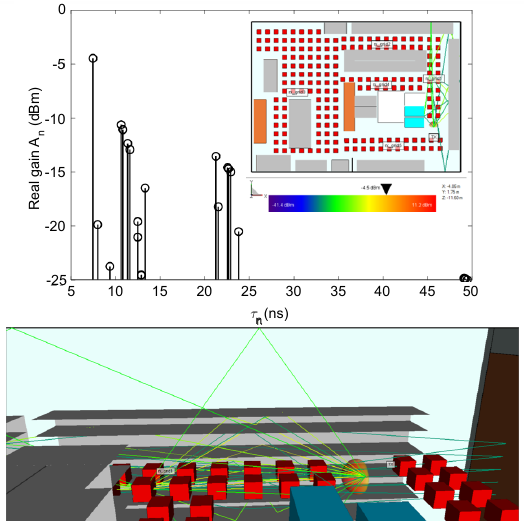
Figure 5. Impulse response at the receiver point 11 in receiver grid 1 (LOS area) with 2D and 3D view of the propagation paths in empty shelves